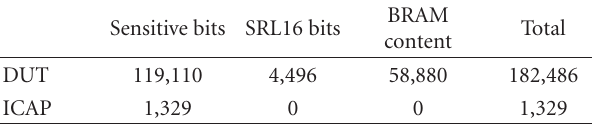
Table 5: Summary of sensitive